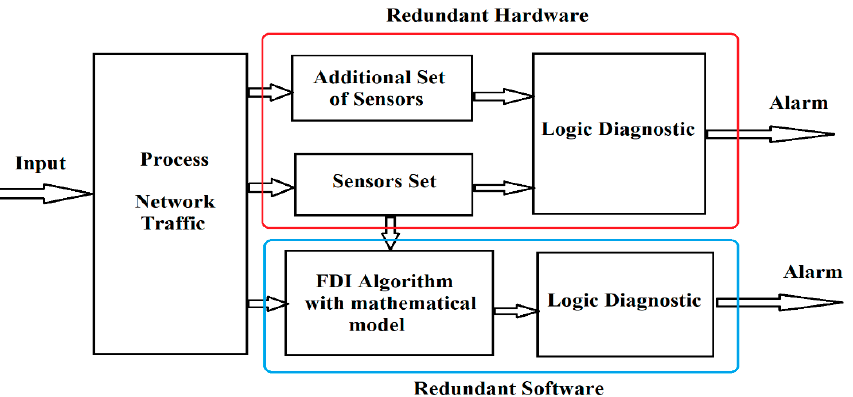
Figure 8. Hardware redundancy and software redundancy (analytical) applied for fault detection and isolation (FDI). and isolation